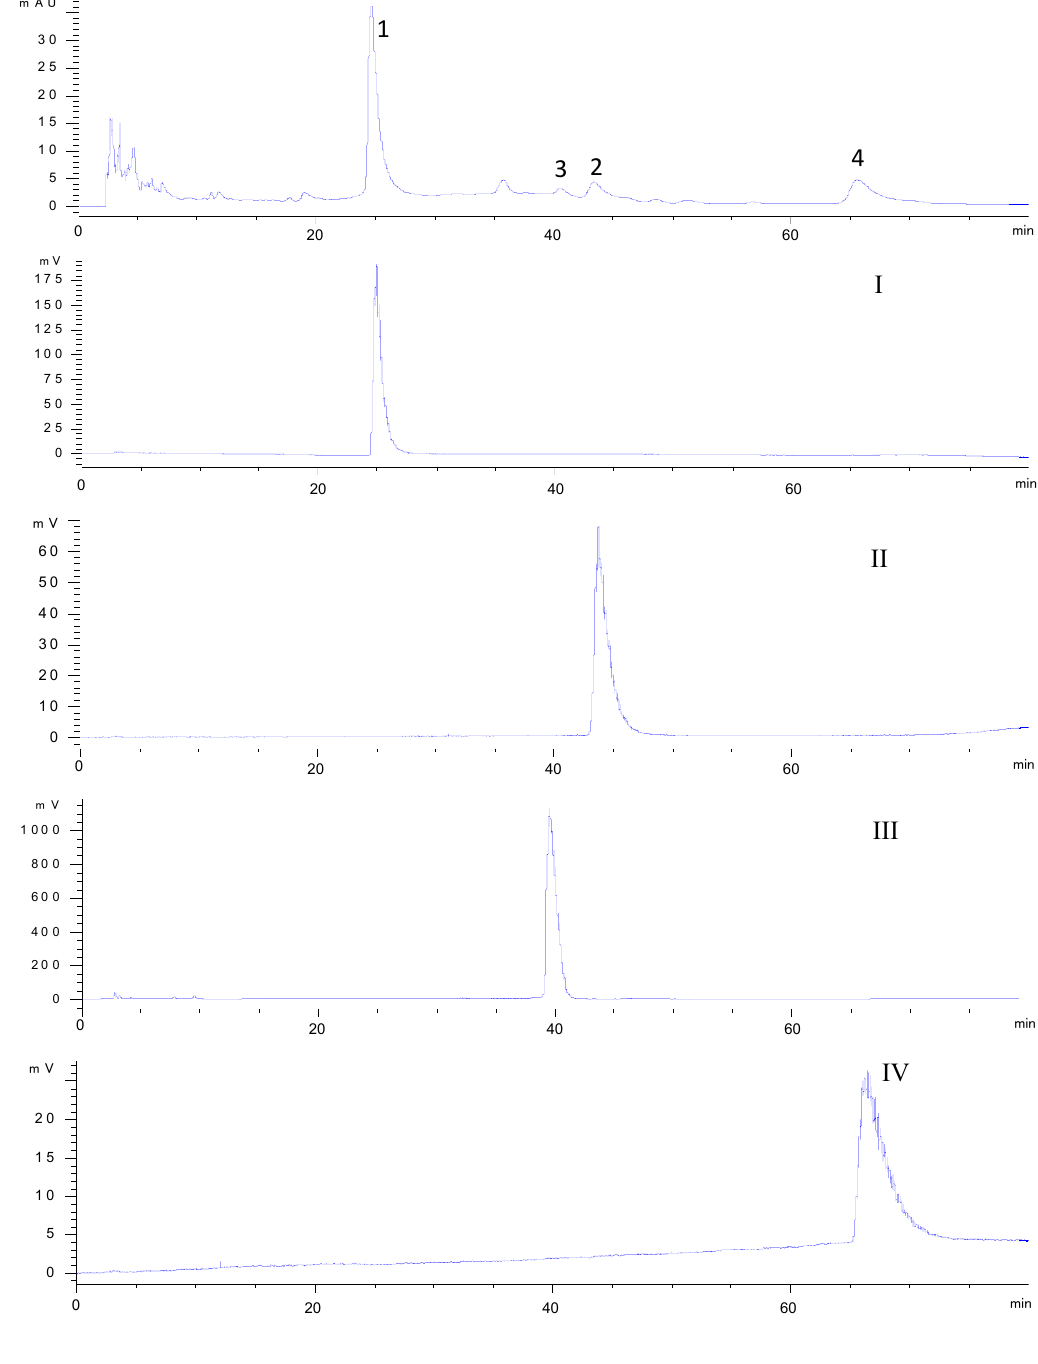
Figure 2. HPLC-UV/ELSD chromatograms of enriched crude extract and the four